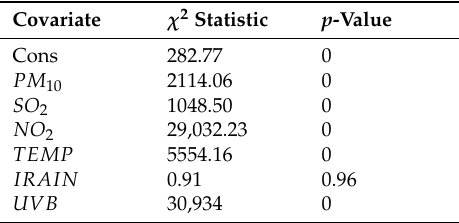
Table 4. χ 2 tests for significance of fixed